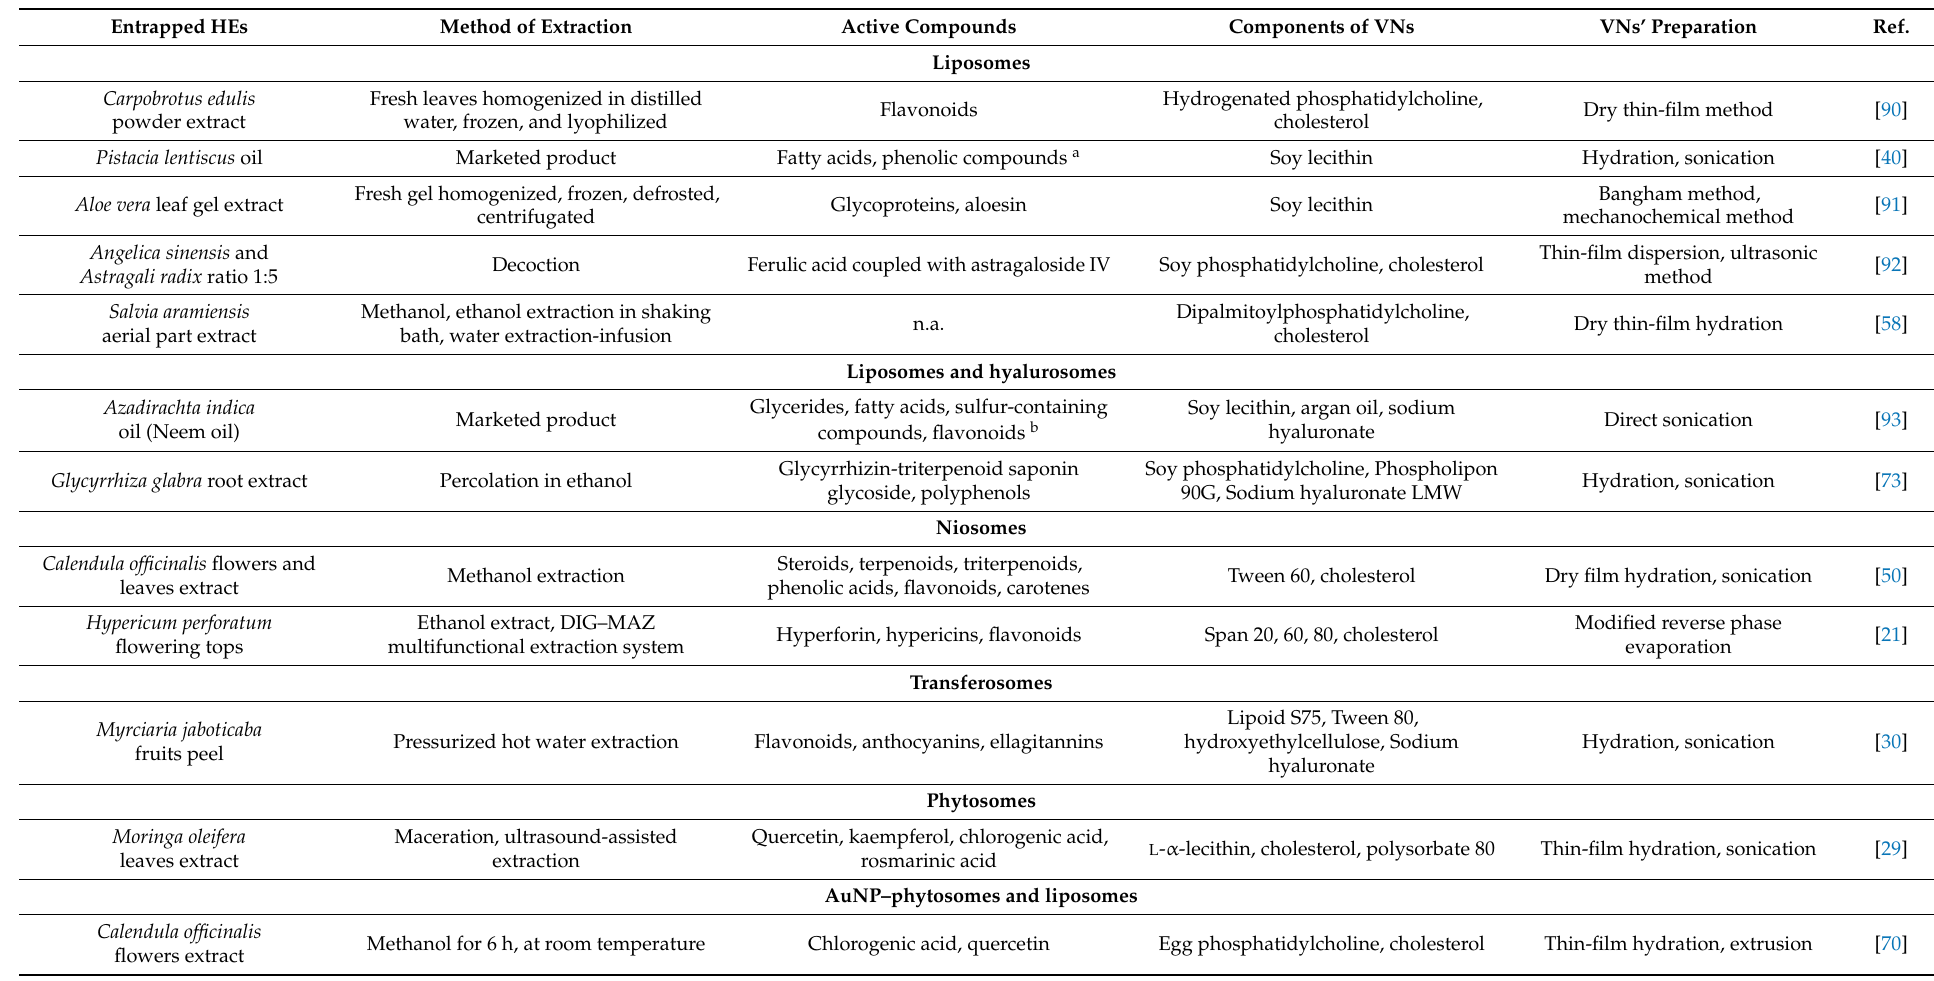
Table 1. Vesicular nanosystems as carriers of herbal extracts with wound-healing